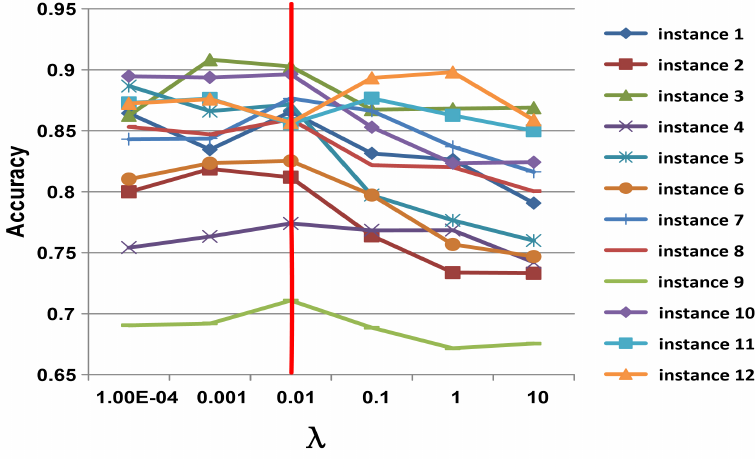
Figure 7. Parameter influence on λ of SCSA on ImageNet dataset. The y-axis represents the classifica- tion accuracy of the target domain; the x-axis represents the value range of λ